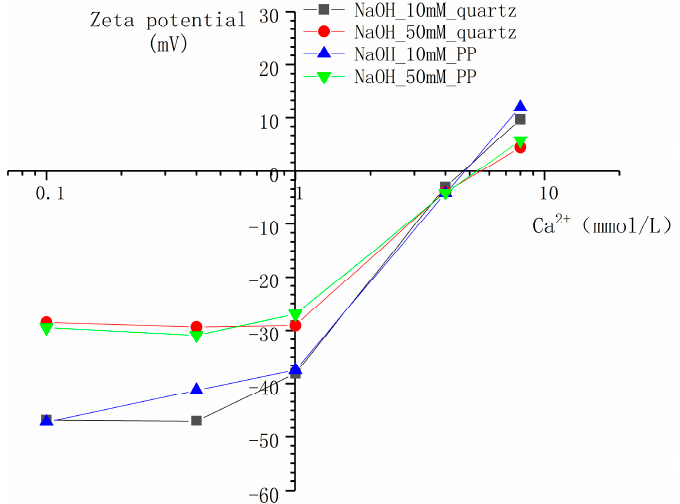
Figure 6. Evolution of the zeta potential of PP and quartz particles as a function of Ca 2+ concentration in 10 mmol/L and 50 mmol/L NaOH solutions.